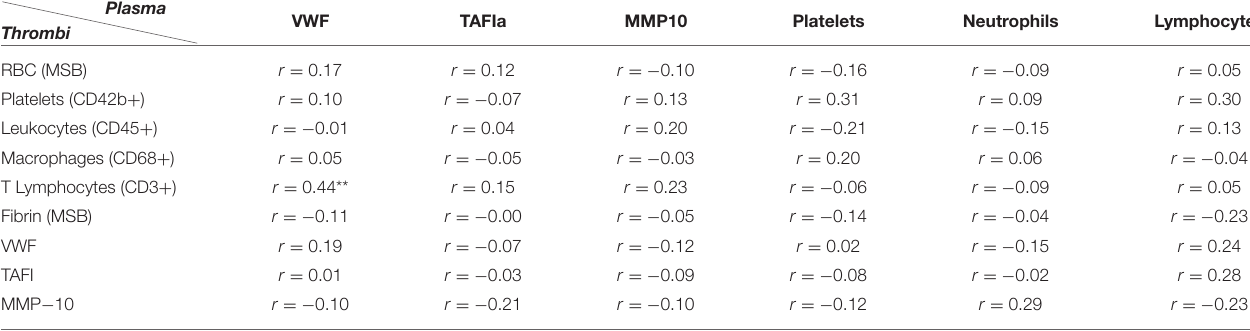
TABLE 4 | Correlations between elements in stroke thrombi and circulating parameters. Plasma Thrombi